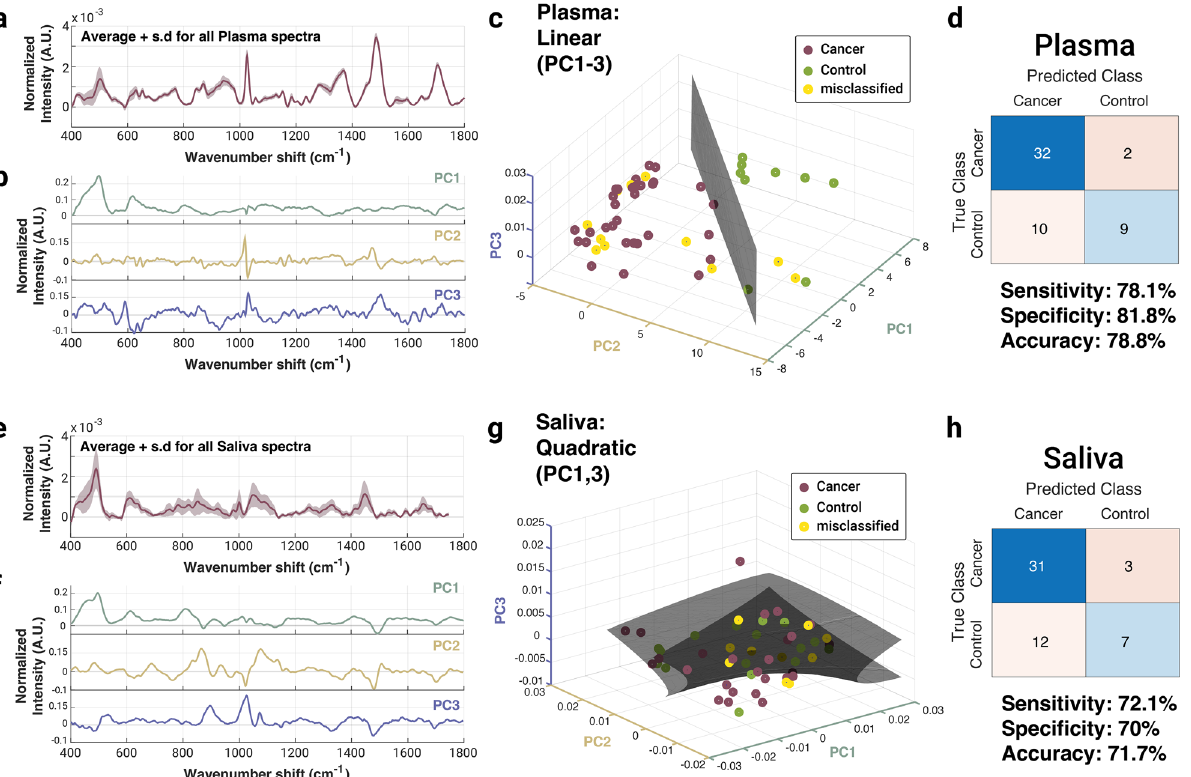
Figure 4. Representative spontaneous Raman data for dried plasma and saliva samples. ( a ) Average spectra and standard deviation for all plasma measurements are plotted. ( b ) Principal component (PC) loadings for PCs 1, 2, and 3 show the major spectral variations amongst the samples. ( c ) The plane of best separation following LDA/ QDA algorithm optimization, with cancer (magenta dots) moderately separated from control (green dots) and several misclassified samples (yellow dots). ( d ) 2 × 2 table generated from the best classifier and their associated sensitivity, specificity, and accuracy. ( e ) Average spectra and standard deviation for all saliva measurements are plotted. ( f ) Principal component (PC) loadings for PCs 1, 2, and 3 show the major spectral variations amongst the samples. ( g ) The plane of best separation following LDA/QDA algorithm optimization, with cancer (magenta dots) moderately separated from control (green dots) and several misclassified samples (yellow dots). ( h ) 2 × 2 table generated from the best classifier and their associated sensitivity, specificity, and accuracy.Plasma analysis yielded higher diagnostic capabilities but overall the technical performance was only moderate.